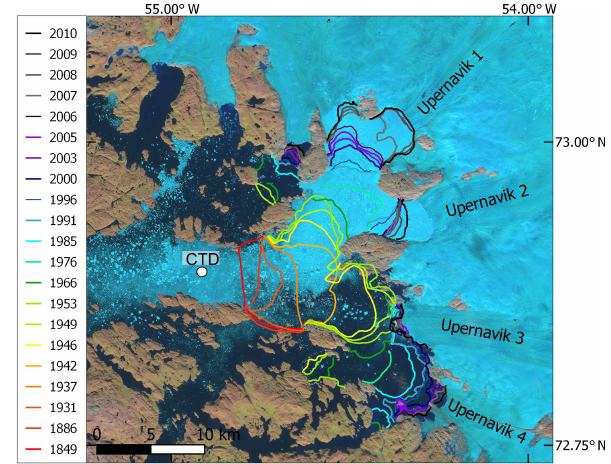
Figure 2. Satellite image (31 July 2018, Sentinel-2B) with the his- torical record of front observations of Upernavik Isstrøm and lo- cation of CTD profile, presented in Fig. 1 (Andresen et al., 2014; Khan et al., 2013; Weidick,